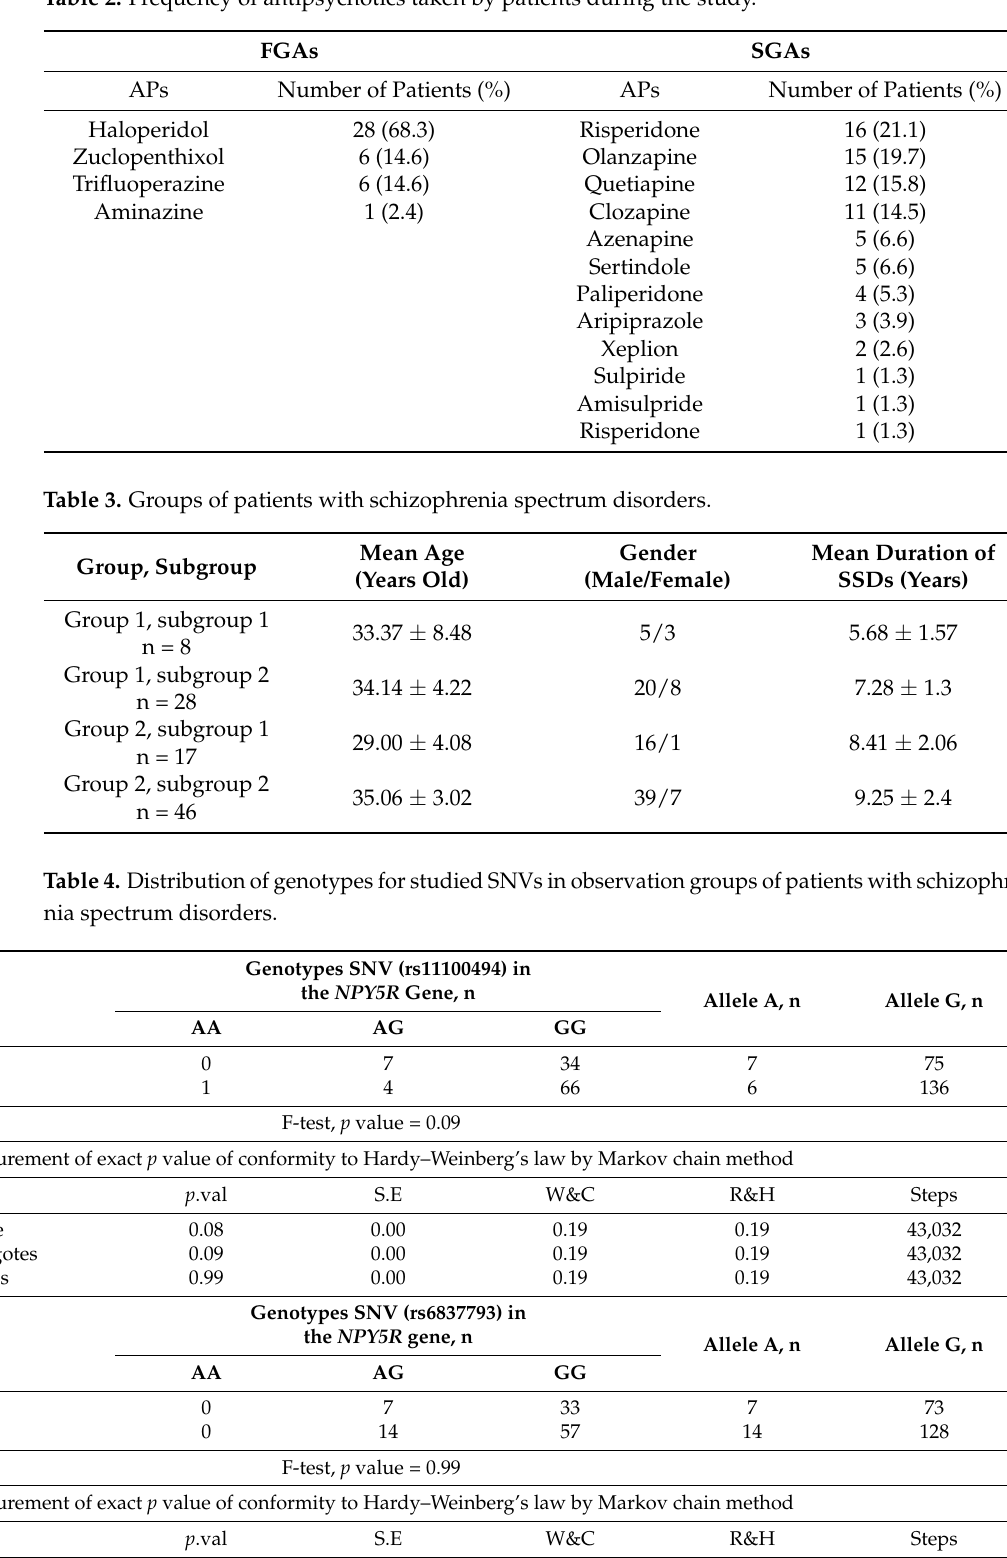
Table 2. Frequency of antipsychotics taken by patients during the study.